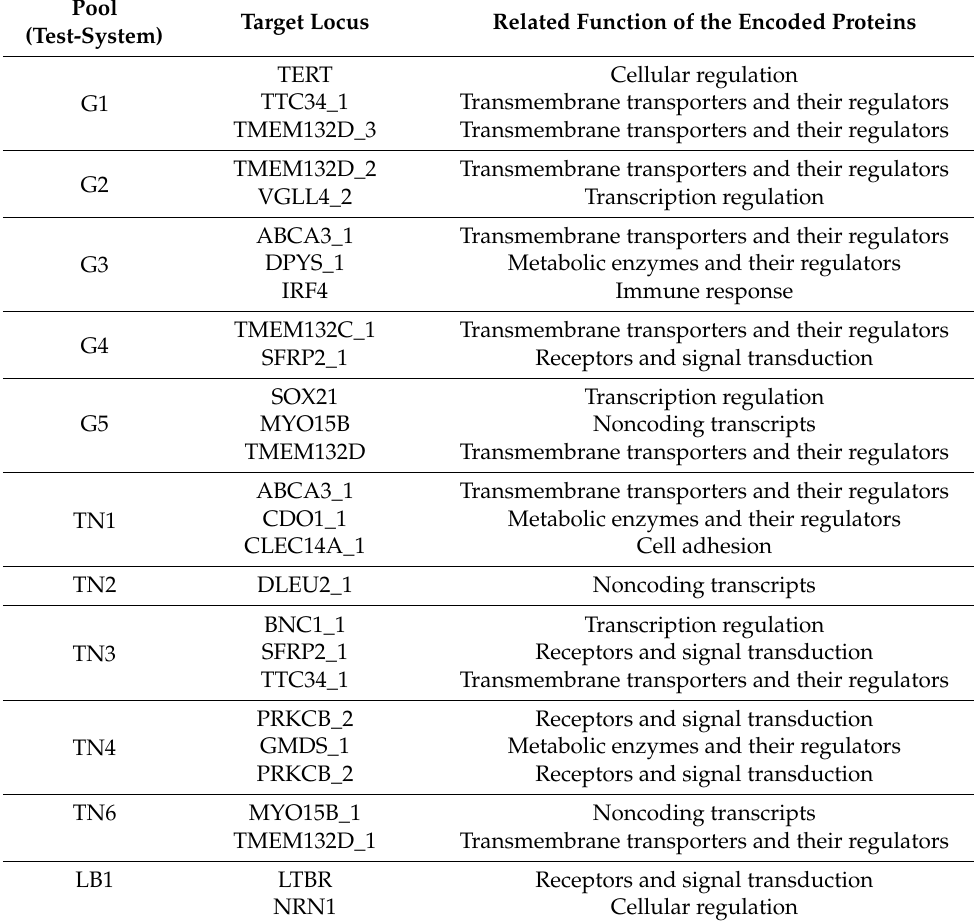
Table 2. Methylation marker genes selected for MSRE-qPCR assays and the function of proteins encoded by these